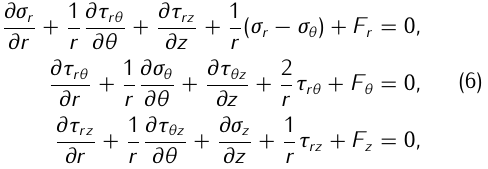
Fig.4. Schematic of parameters used in the impeller Figure 4. Schematic of parameters used in the